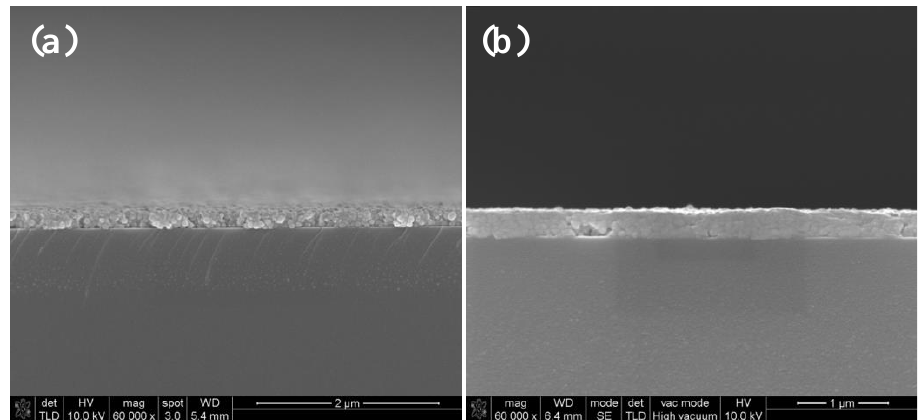
Figure 5. Photo of silver films based on NP ink after the tape test: ( a ) Heat cured in 80 °C for 30 min; ( b ) heat cured in 140 °C for 30 min; ( c ) UV cured at D = 37 cm for 180 s; ( d ) UV cured at D = 25 cm for 480 s.